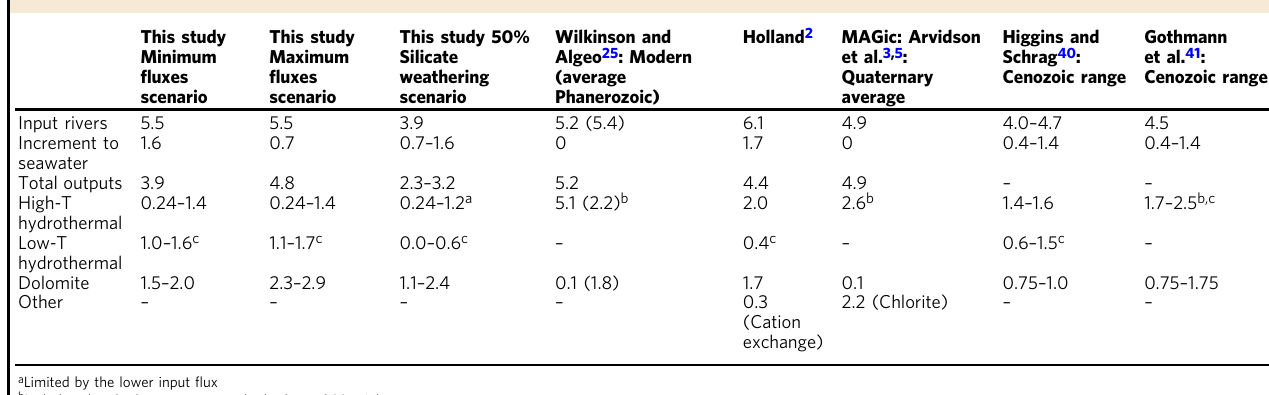
Table 2. The resulting F LTH (1.0 – 1.7 Tmol yr − 1 ; ~20 – 40% of the total Mg outputs) imply that the average [Mg] LTH is between